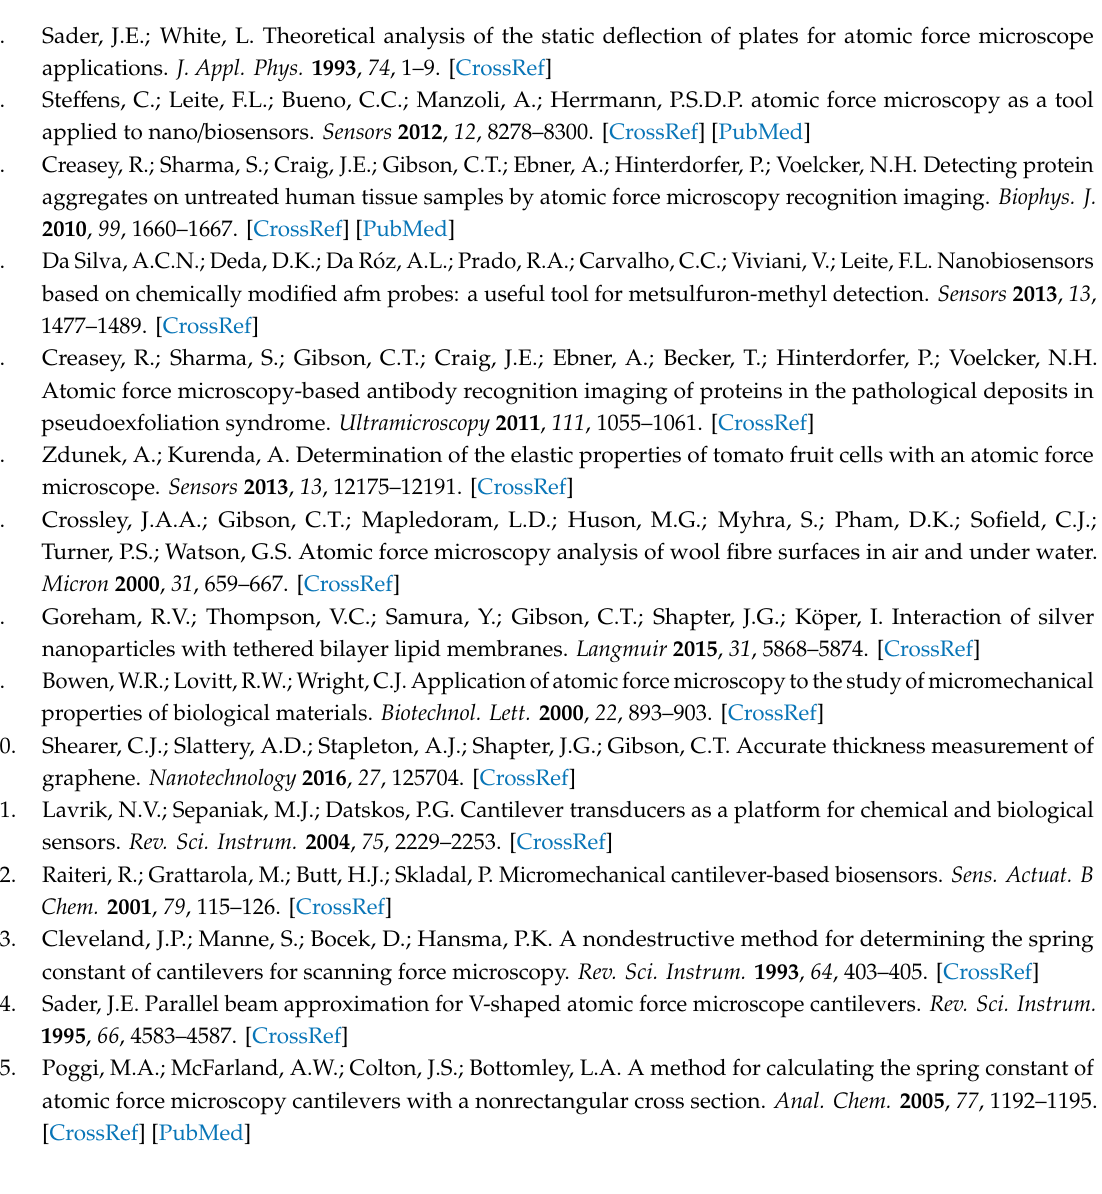
Table S1: Default or nominal values for the cantilever types FastScan A, B and C provided by Bruker (Bruker Corporation, Billerica, MA,